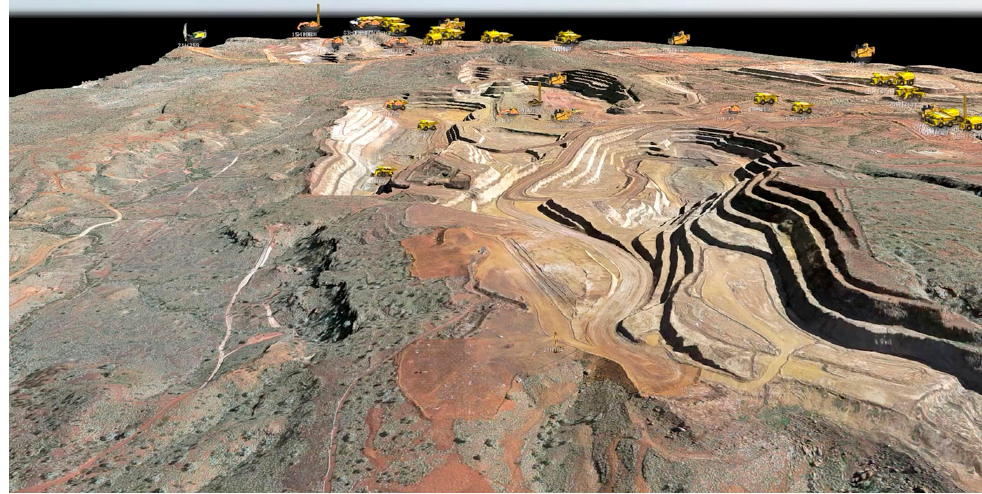
Figure 9. Visualization of open pit mining using a 3D model built using smart sensors in real-time (Reprinted from Ref. [83]).